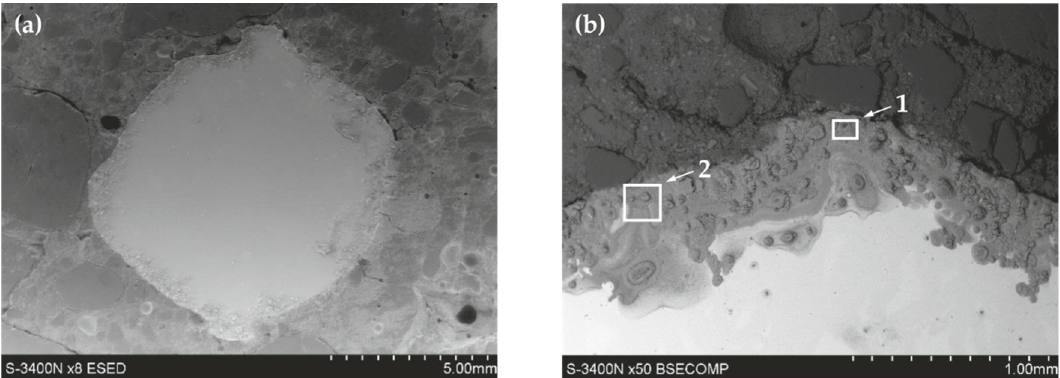
Figure 13. Microstructure of the joint between concrete with chlorides and black reinforcing steel B500SP (SEM): ( a ) general view of a cross-section of a steel bar in concrete ( b ) morphology of the boundary of separation rebar – concrete with marked places 1 and 2 for microanalysis of the chemical composition.